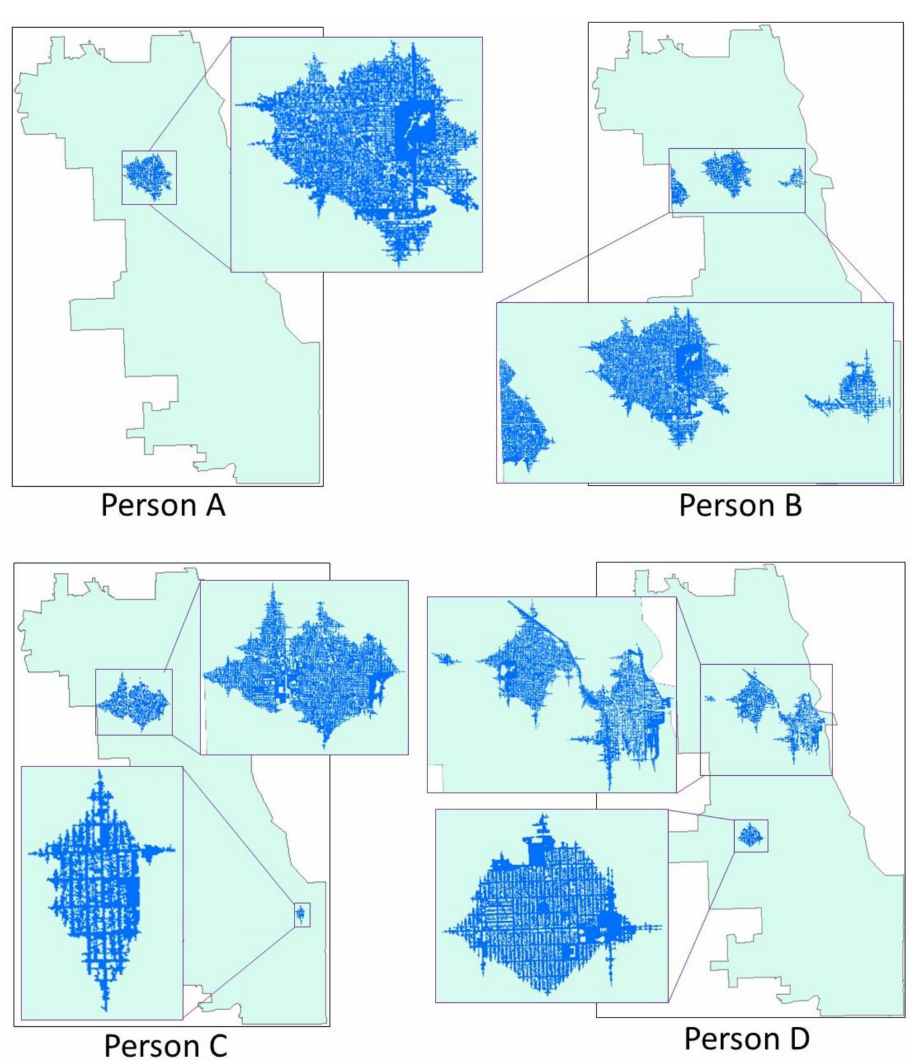
Figure 7. The context-based crystal-growth activity spaces of the four representative